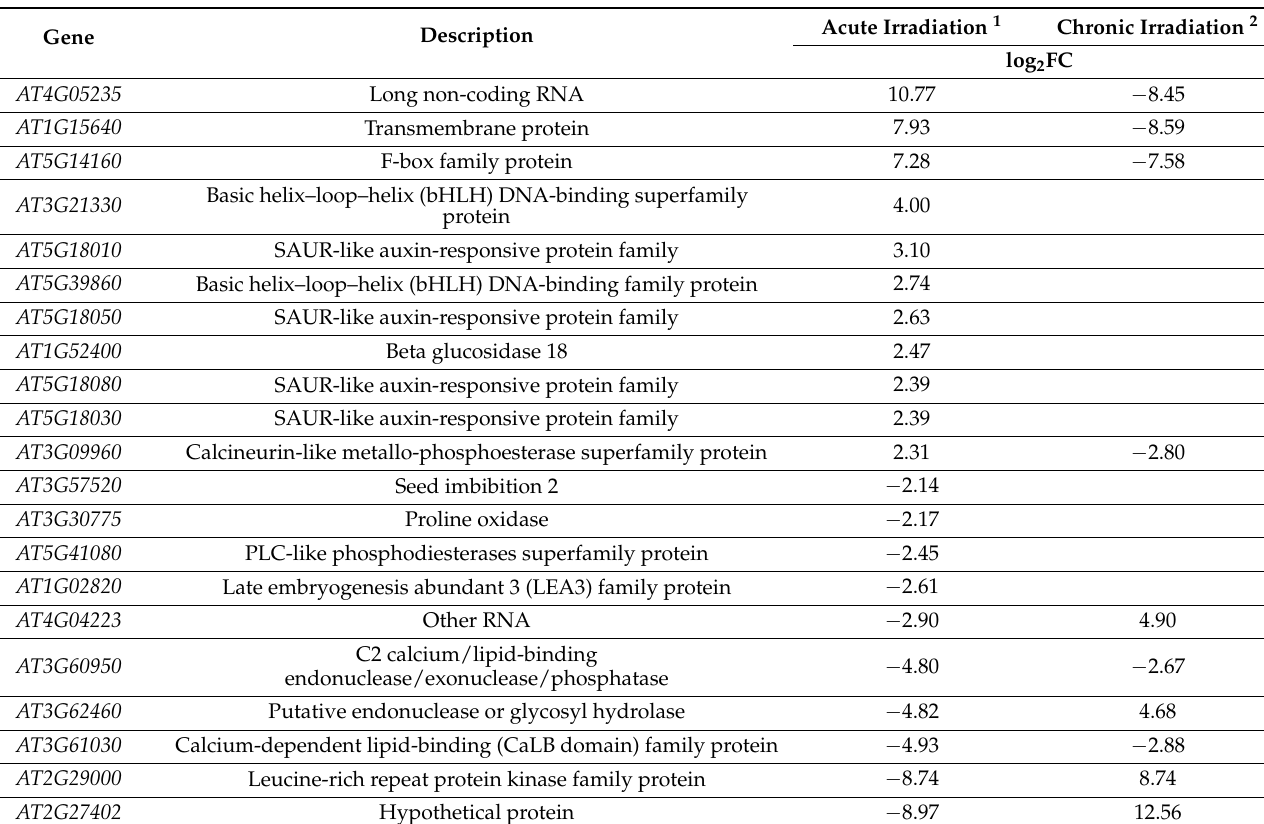
Table 5. Unique DEGs in accession Masa-0 from the most contaminated plot in response to acute and chronic